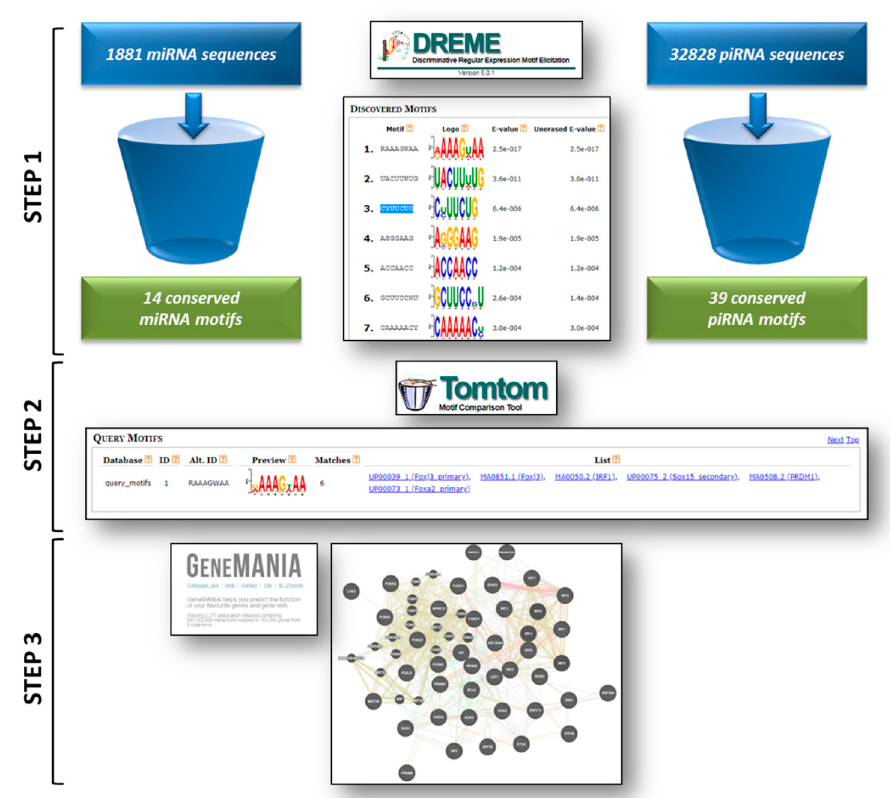
Figure 1. Experimental workflow. A schematic representation of the pipeline integrating the different analytical software is provided. The details of the analytical steps are described in the text (Section 2).